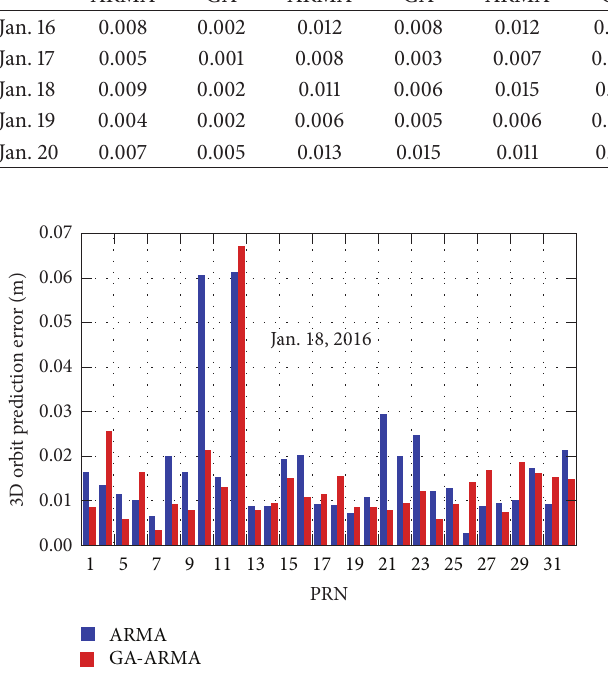
Figure 5: 3D orbit prediction error for each satellite (January 18, 2016).